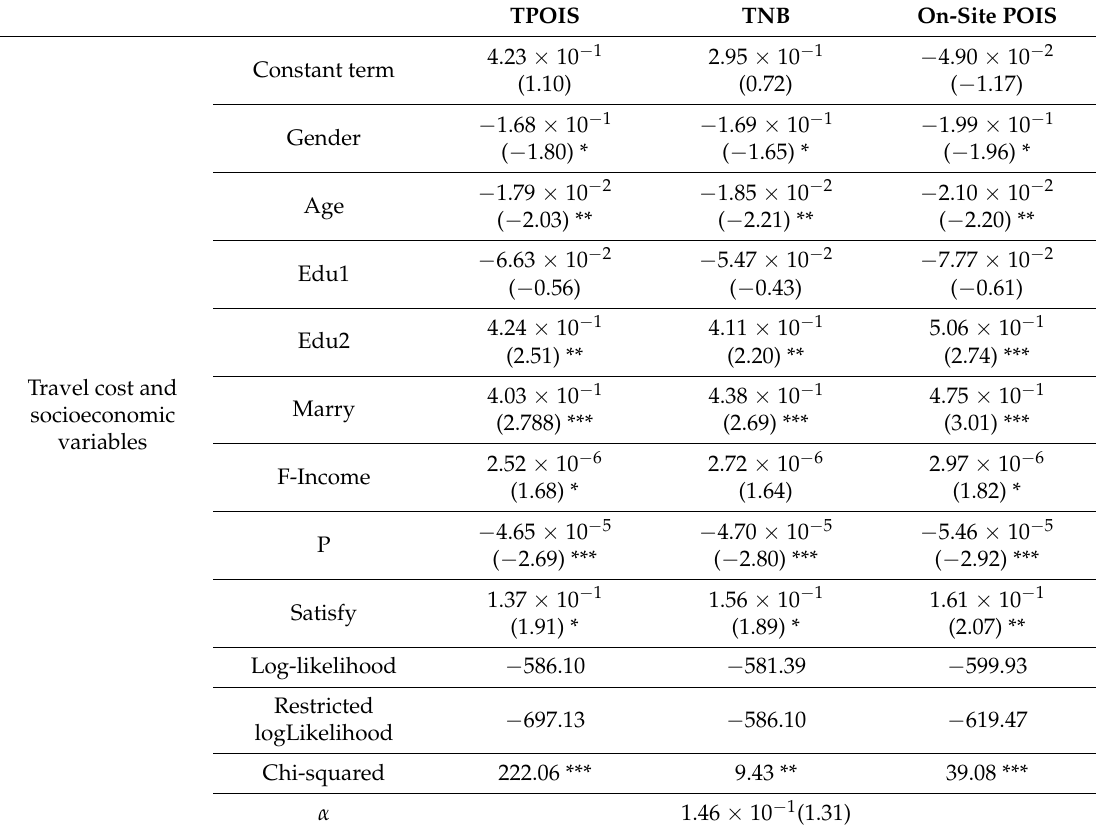
Table 6. Results of the tourism demand